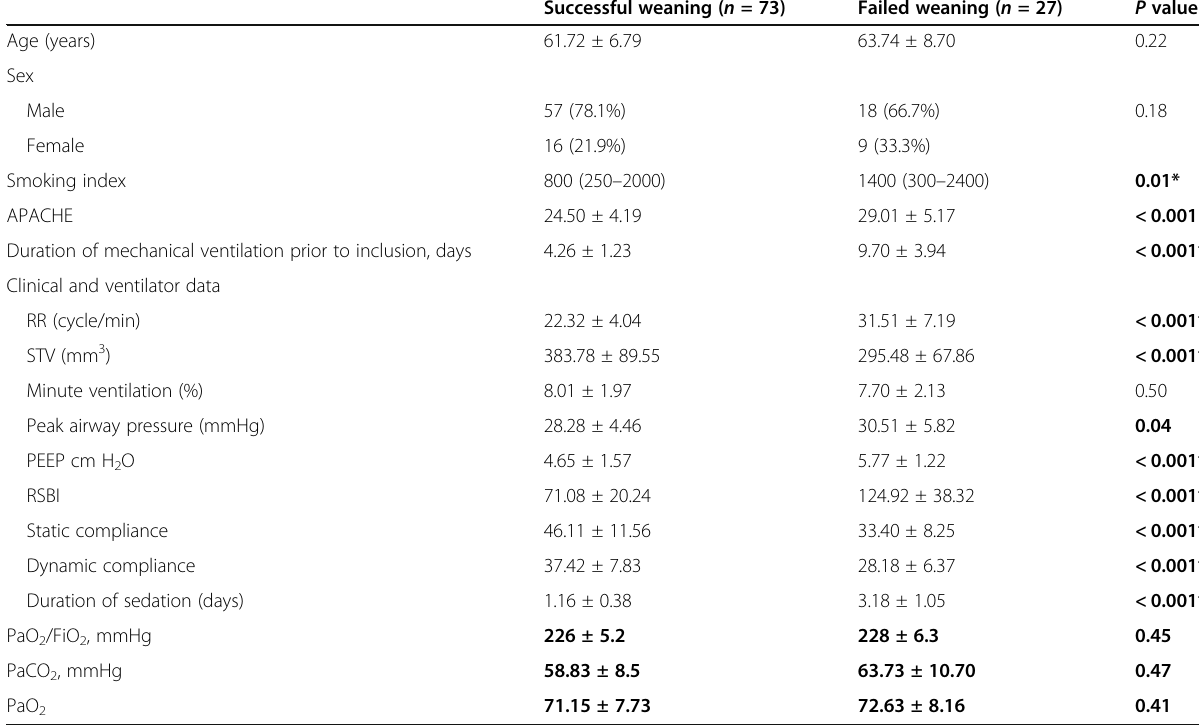
Table 1 Baseline data of studied patients based on weaning outcome